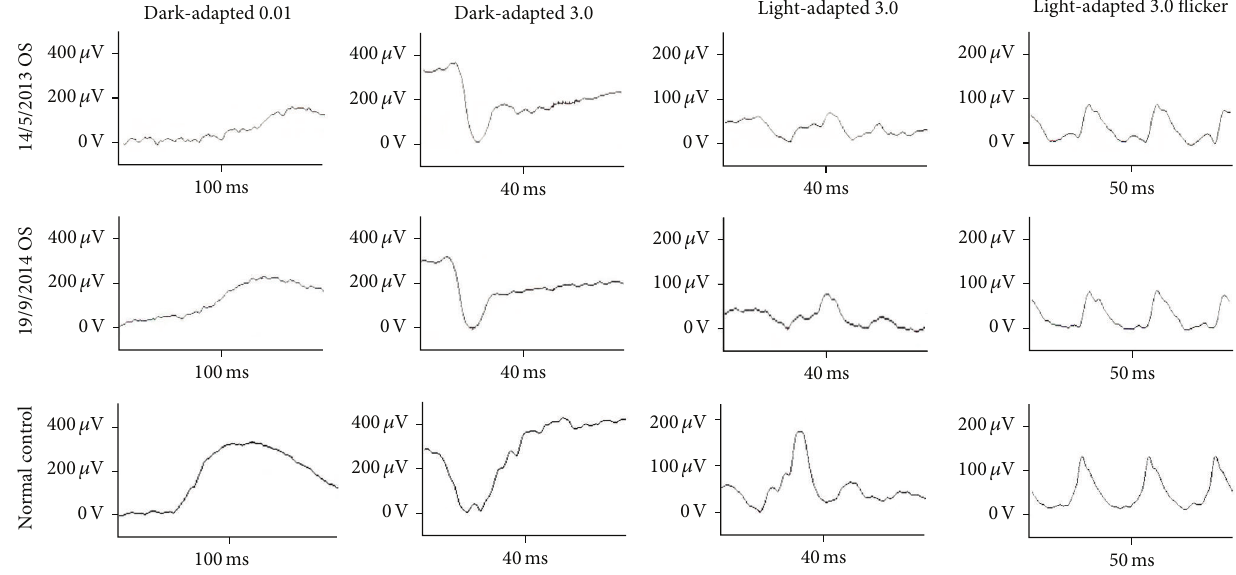
Figure 1: Time course of the changes in the full-field ERGs in the left eye of a patient with XLRS and a normal control is shown. The baseline of full-field ERGs recorded from the left eye of the patient and the same eye after 14 months of follow-up is shown on the top and middle row. The full-field ERGs of the normal control are shown in the bottom row. The dark-adapted 0.01, dark-adapted 3.0, light-adapted 3.0, and light-adapted 3.0 flicker ERGs of the full-field ERGs are shown. The amplitudes and implicit times of the full-field ERGs of the patient during the follow-up do not differ from those at the